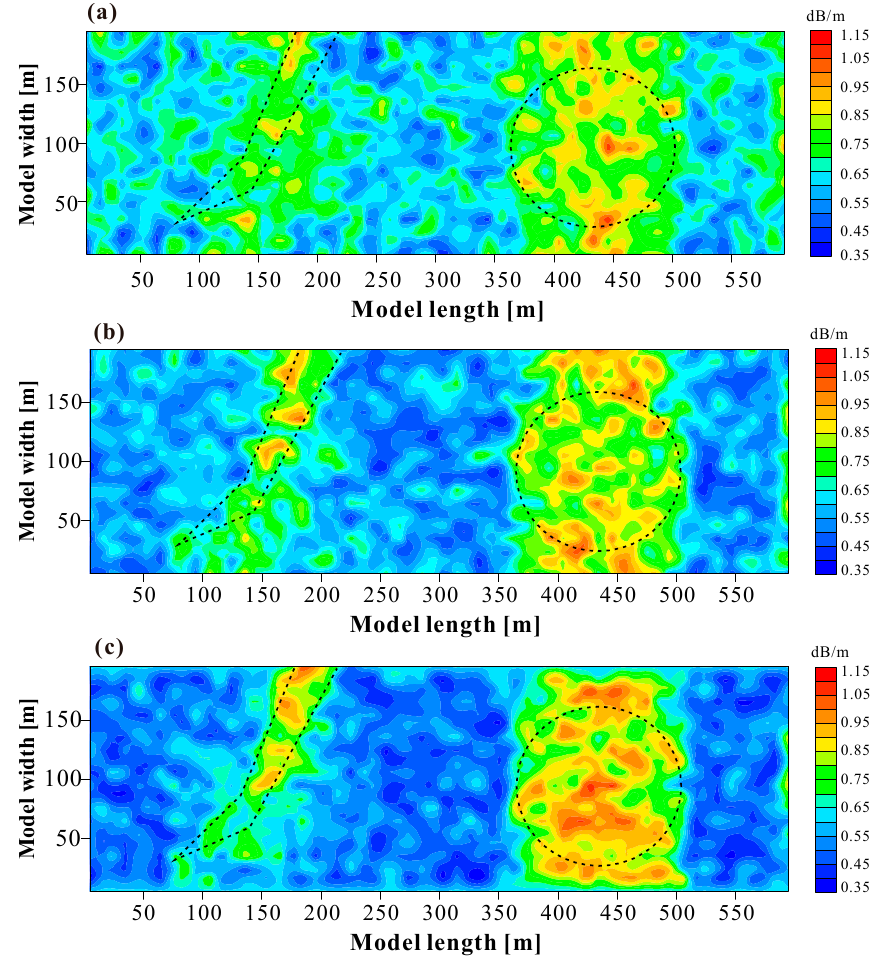
Figure 5. Reconstructed results according to the different algorithms after 500 iterations. ( a ) Inversion result from the simple genetic algorithm (SGA); ( b ) inversion result from the AMPGA; ( c ) inversion result from the AMPGA with constraints.